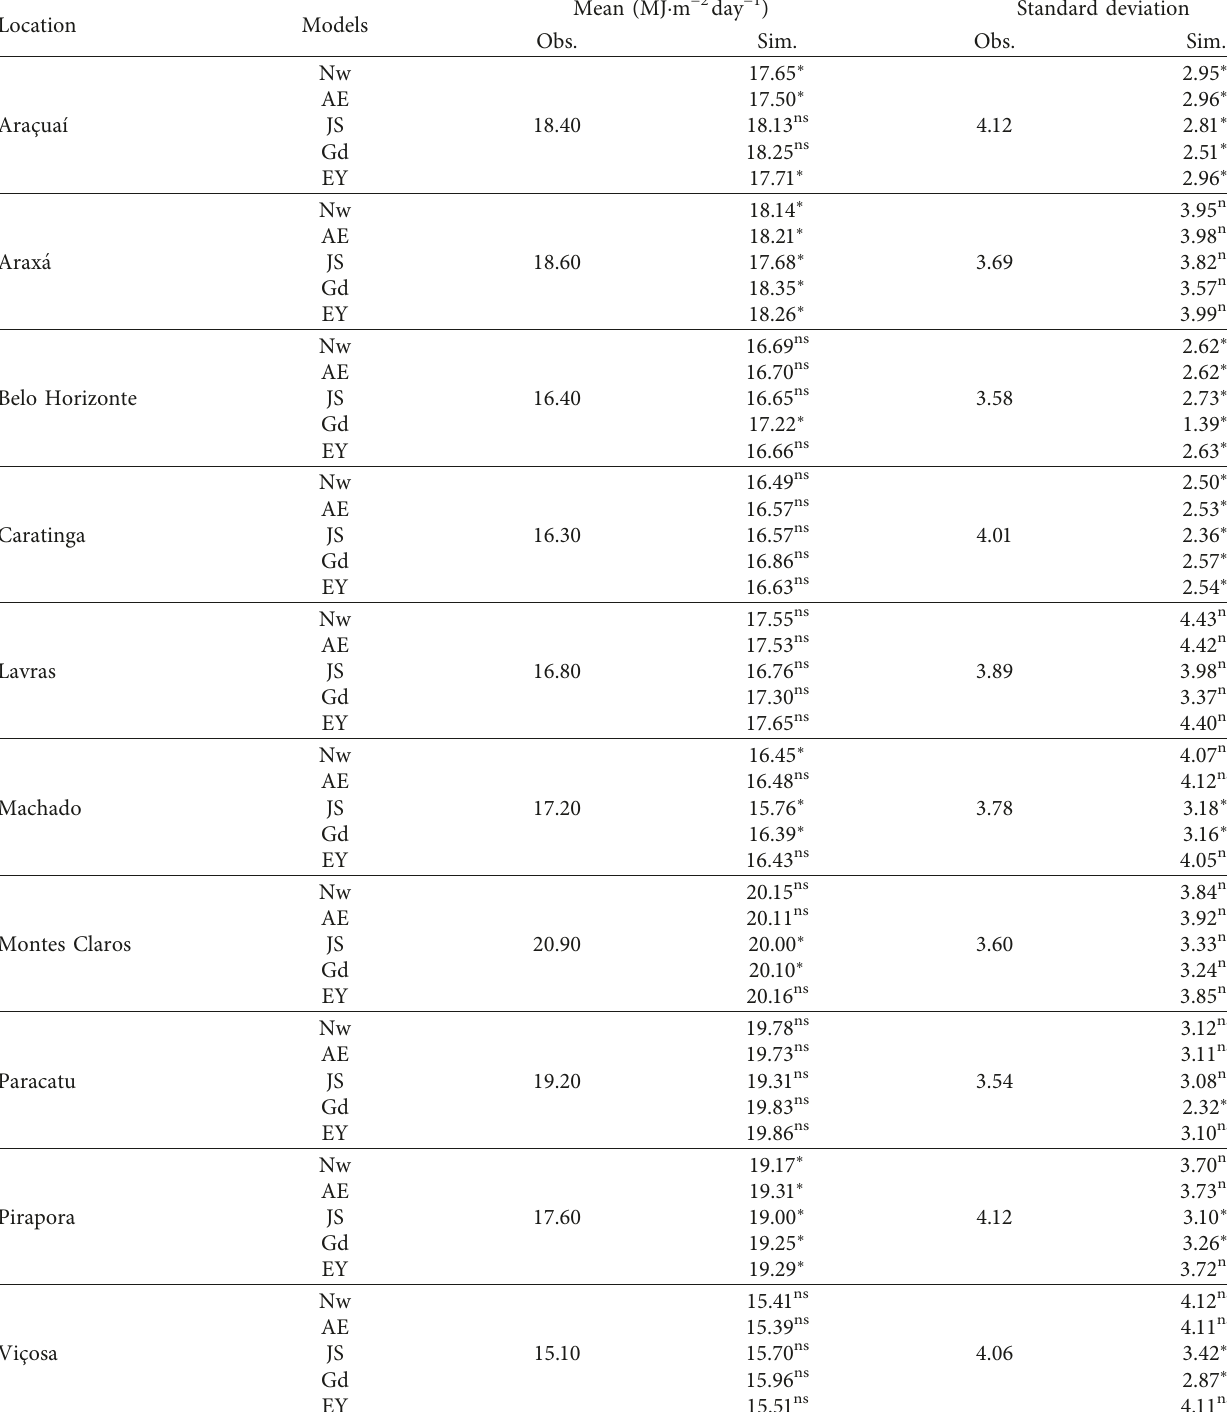
Table 4: Mean and standard deviation related to global solar radiation observed and simulated by the empirical models in each location. Location Models